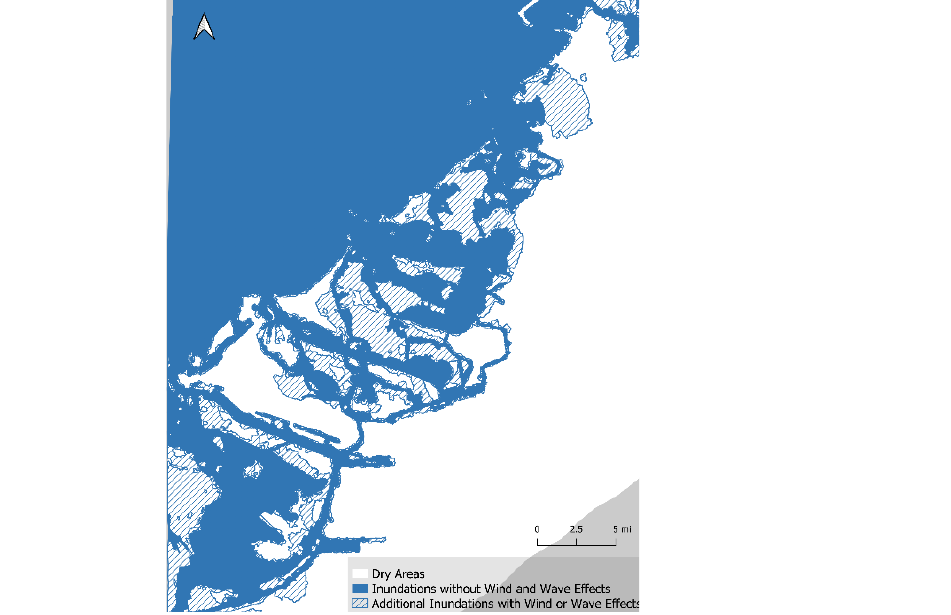
Figure 6. Predicted inundation extent for the Abu Dhabi area — SLR with tidal effect only, with and without the effect of winds or waves.